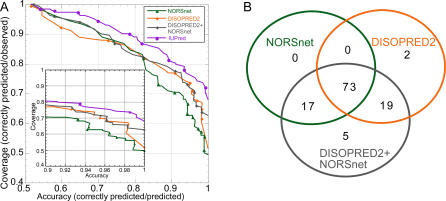
Predictions for DisProt(A) ROC-like curve for NORSnet (green), DISOPRED2 (orange), and their combination (through arithmetic average; gray). While the performance of NORSnet and DISOPRED2 were similar, the combined method seemed to outperform both methods. Particularly, at accuracy = 100% (inset), the combined method covers significantly more sequences than each one of the methods individually. IUPred (purple) outperformed all other methods on this dataset. Note that IUPred was optimized on a set similar to the one used in this study. In contrast, NORSnet and DISOPRED2 were optimized on different sets defining disorder differently.(B) Venn diagram of overlap between very accurate predictions by NORSnet, DISOPRED2, and the combined method. The numbers in the circles are mutually exclusive; for instance, two proteins were identified only by DISOPRED2 to have an unstructured region, and 17 proteins were identified by both NORSnet and by the combined method to have an unstructured region.